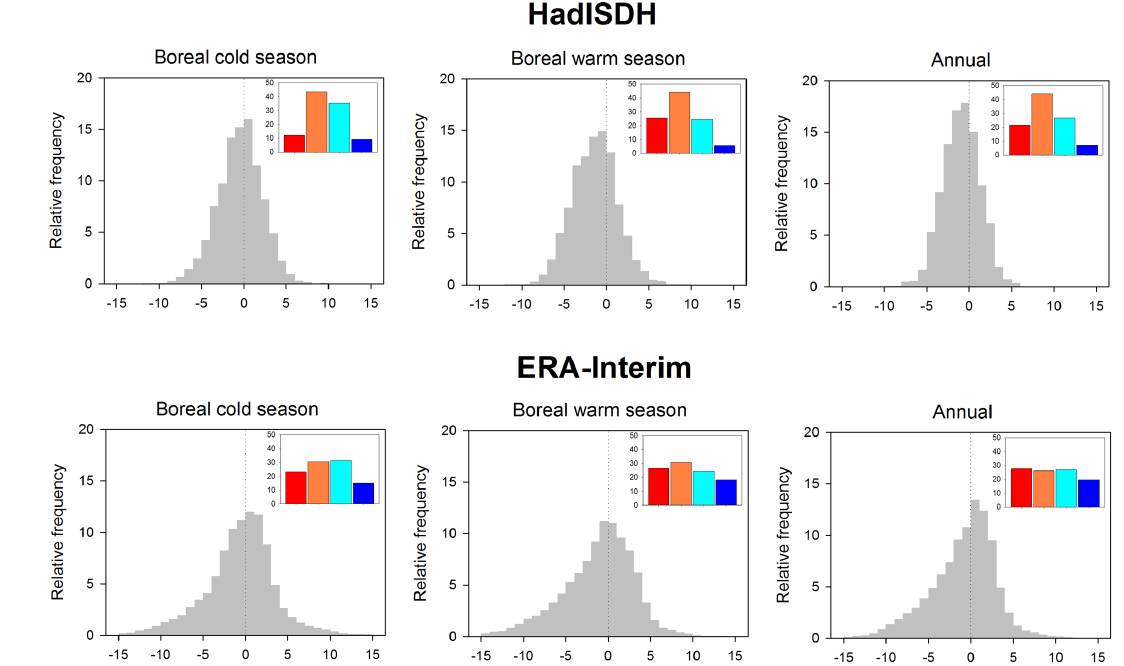
Figure 2. Relative frequencies (%) of the RH magnitude of change in the HadISDH and ERA-Interim datasets. Color bar plots represent the percentage of stations (from HadISDH) and world regions (from ERA-Interim) with statistically significant positive trends at p <0.05 (blue), statistically insignificant positive trends (cyan), statistically insignificant negative trends (orange), and statistically significant negative trends